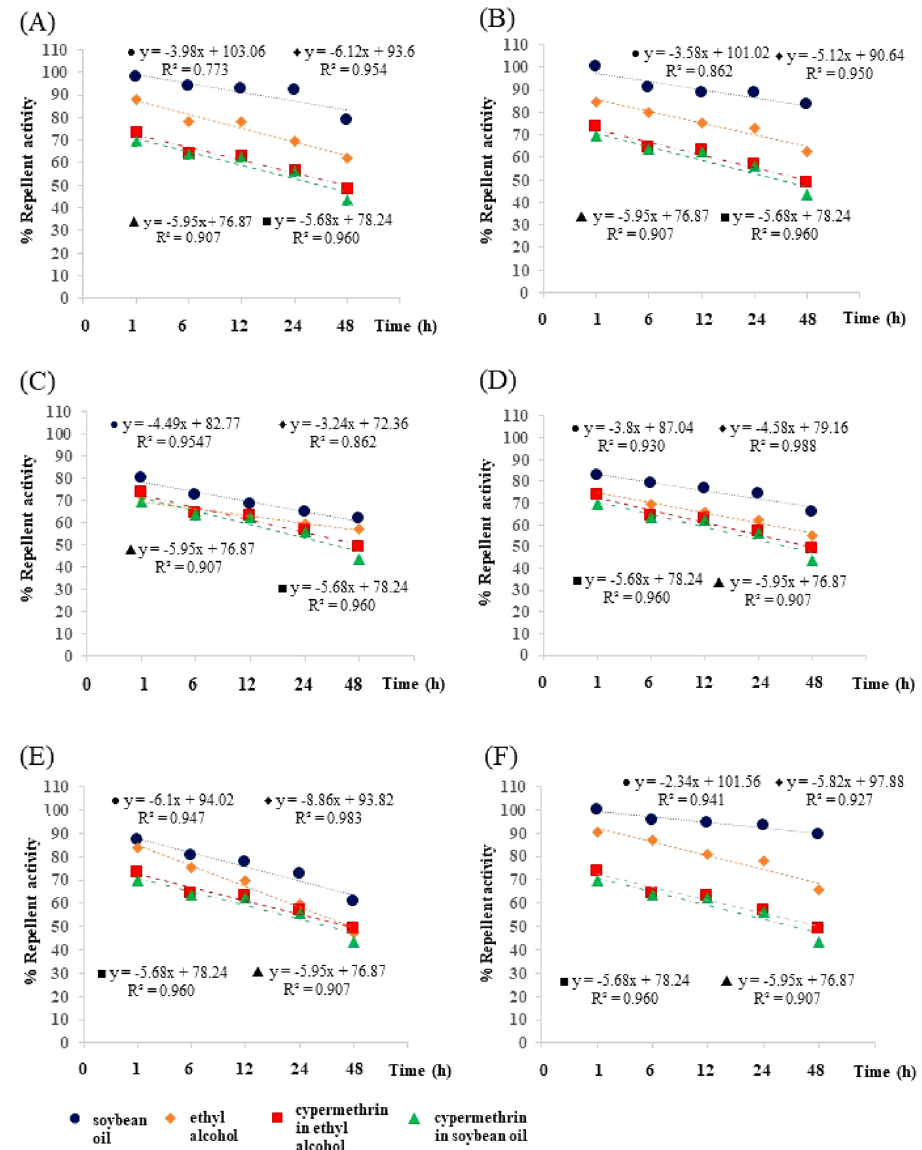
Figure 3. Relationships between percentage repellent activity and time (h) of five essential oils (EOs) and a combined formulation of two EOs in soybean oil and in ethyl alcohol against Periplaneta americana , compared to that of cypermethrin: C . citratus EO ( A ), C . verum EO ( B ), E . globulus EO ( C ), I . verum EO ( D ), Z . limonella EO ( E ), and 5% I . verum EO + 5% C . verum EO ( F ). Note: blue line represents the relationship between percentage repellent activity and time for each EO in soybean oil, orange line represents the same kind of relationships for each EO in ethyl alcohol, red line represents the relationship between percentage repellent activity and time for cypermethrin in soybean oil, and green line represents the same kind of relationship for cypermethrin in ethyl